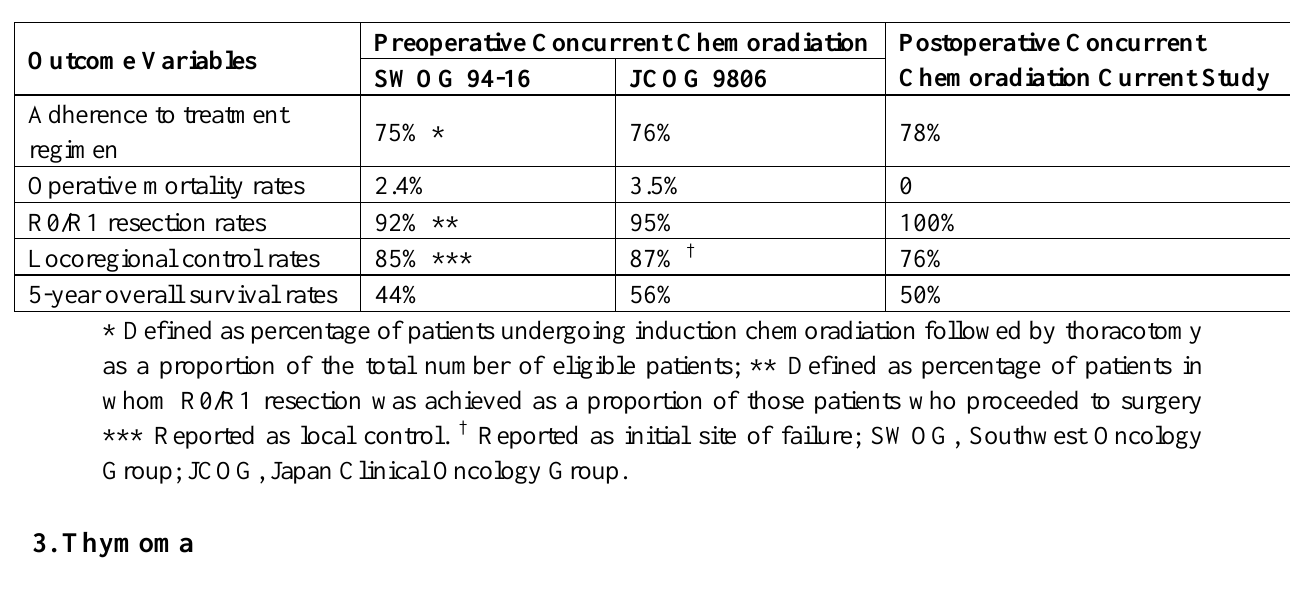
Table 2. Comparison of preoperative with postoperative radiation in prospective trials (from Gomez et al . [43] and comparing this postoperative radiation trial with studies from the Southwest Oncology Group [31,32] and JCOG 9806